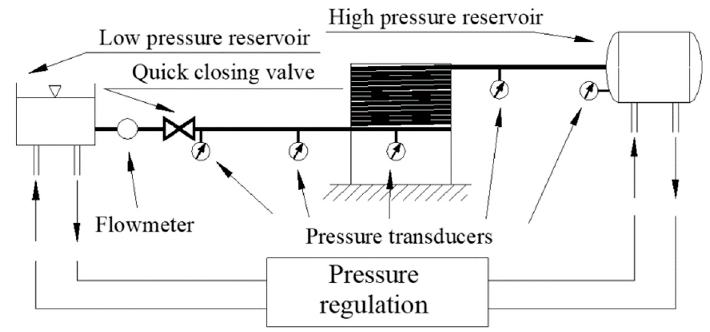
Figure 4. Gdansk Institute of Fluid-Flow Machinery test rig. Figure 4. Gda´nsk Institute of Fluid-Flow Machinery test